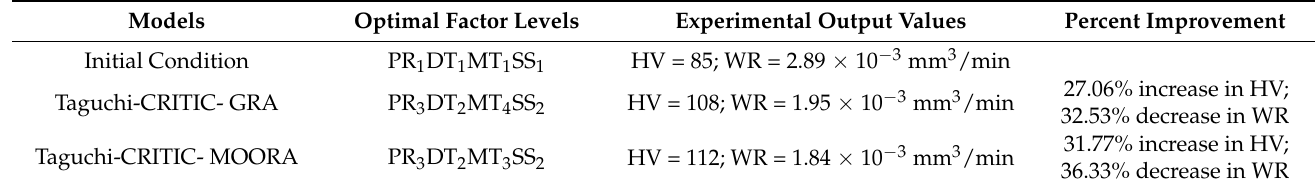
Table 13. Confirmation experiments results of optimized